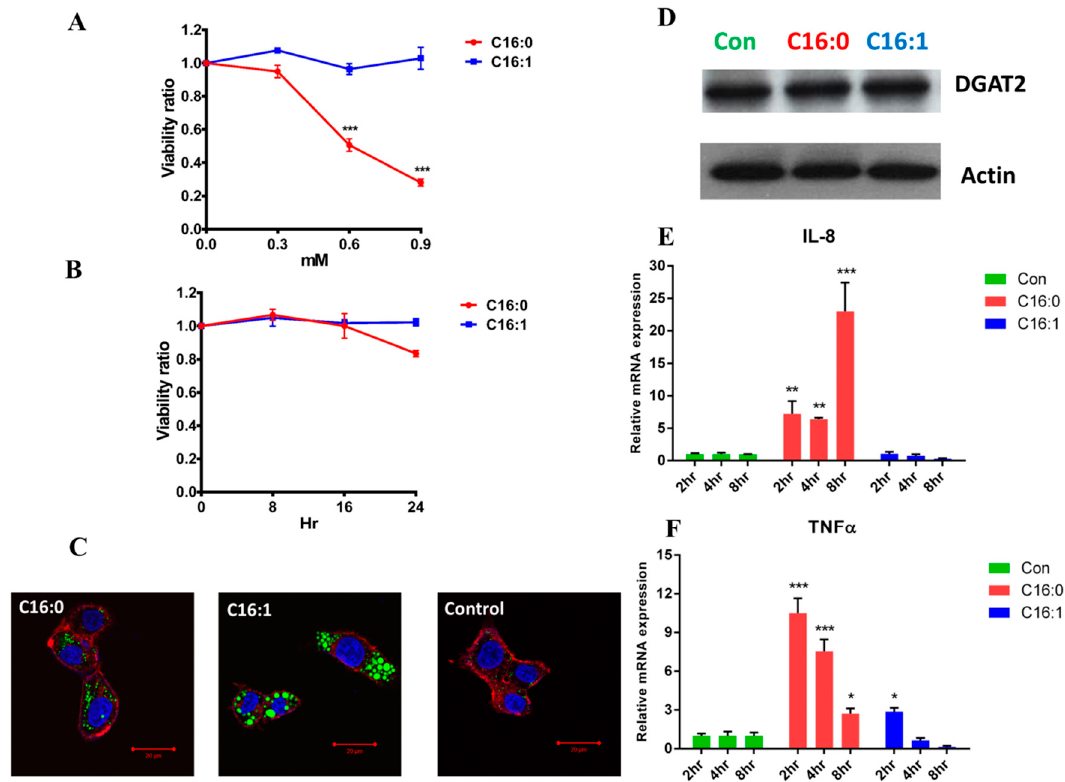
Figure 1. The viability of FFA-treated HepG2 cells was detected using fluorescent cell viability assays. ( A ) The dosage-dependent 24-h incubation with 0.3, 0.6, and 0.9 mM FFAs and ( B ) the time-dependent incubation with 0.3 mM FFAs. These results were representative of at least three separate experiments. ( C ) Observation of lipid droplets in HepG2 cell using BODIPY (493/503) staining. The cells were incubated with 0.3 mM FFAs for a 16-h treatment. Green illumination represented neutral lipid, red illumination represented F-actin, and blue illumination represented the nucleus. ( D ) The protein expression level of diglyceride acyltransferase 2 (DGAT2) was determined by western blot analysis. ( E ) The TNF- α and ( F ) IL-8 mRNA expression level after treatment with 0.3 mM FFAs for 2-, 4-, and 8-h incubation. The value of relative mRNA expression was normalized to the control Actin gene. (* p < 0.05, ** p < 0.01, *** p < 0.001).